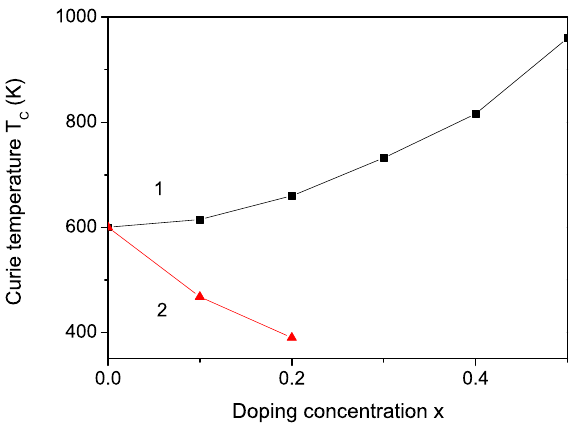
Figure 3. Dependence of the Curie temperature T C in CCO NP with N = 20 shells on the ion doping concentration x for (1) Co with J d = 1.2 J b ; (2) La with J d = 0.8 J b